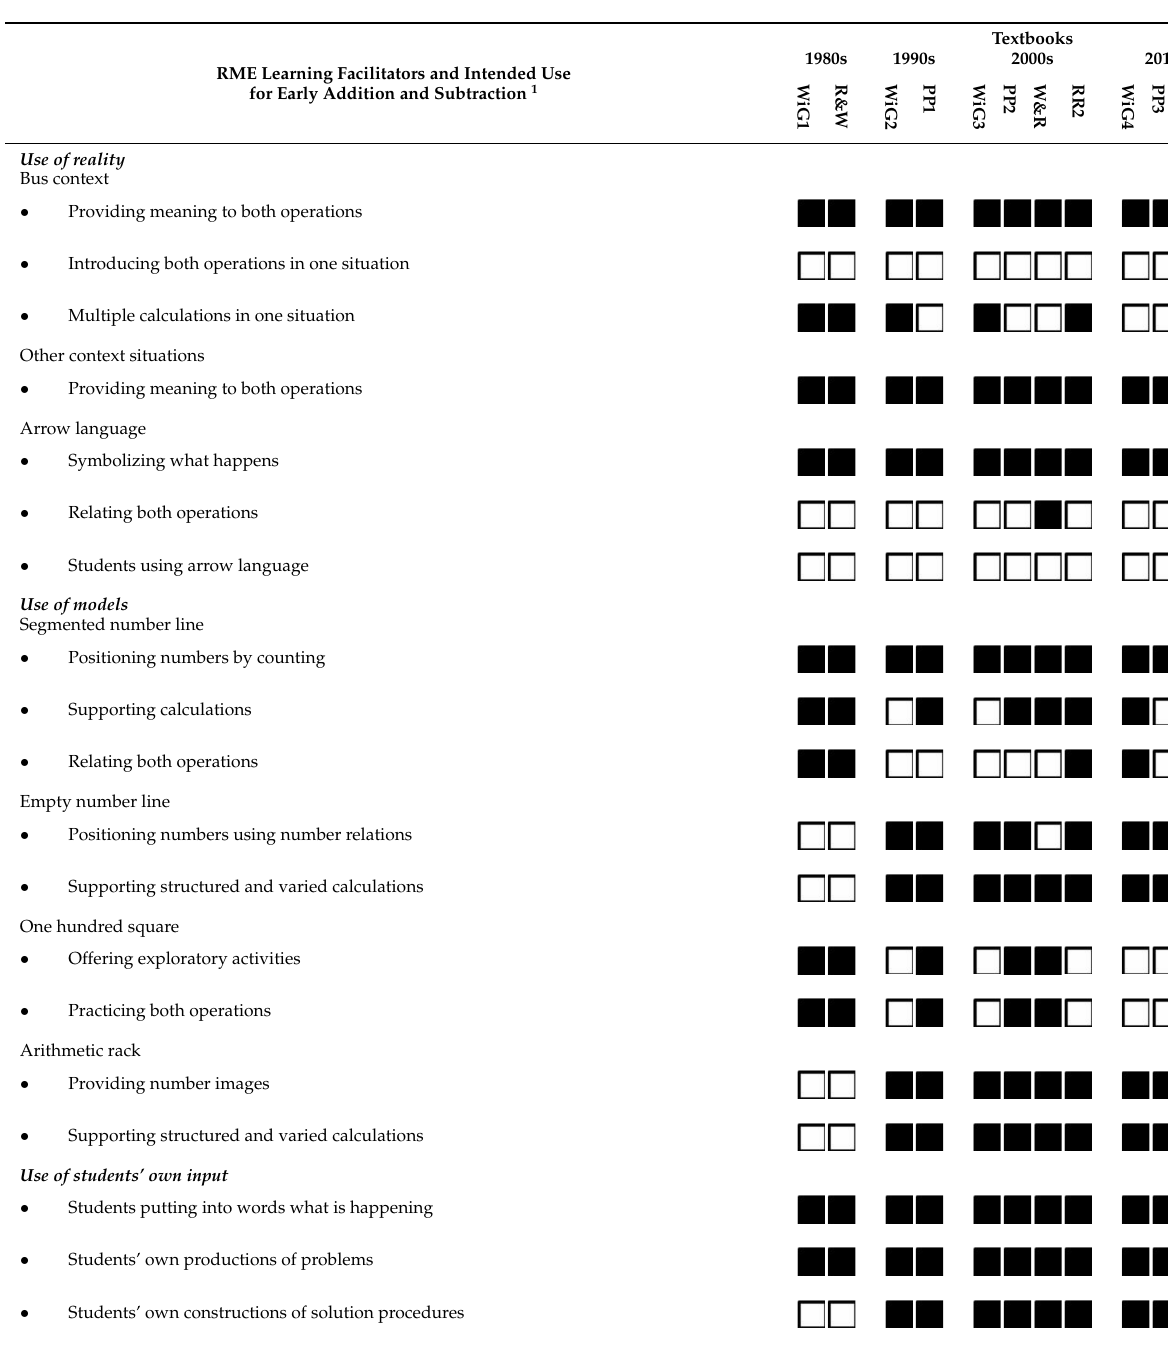
Table 3. RME learning facilitators and their intended use for early addition and subtraction as included in RME-oriented